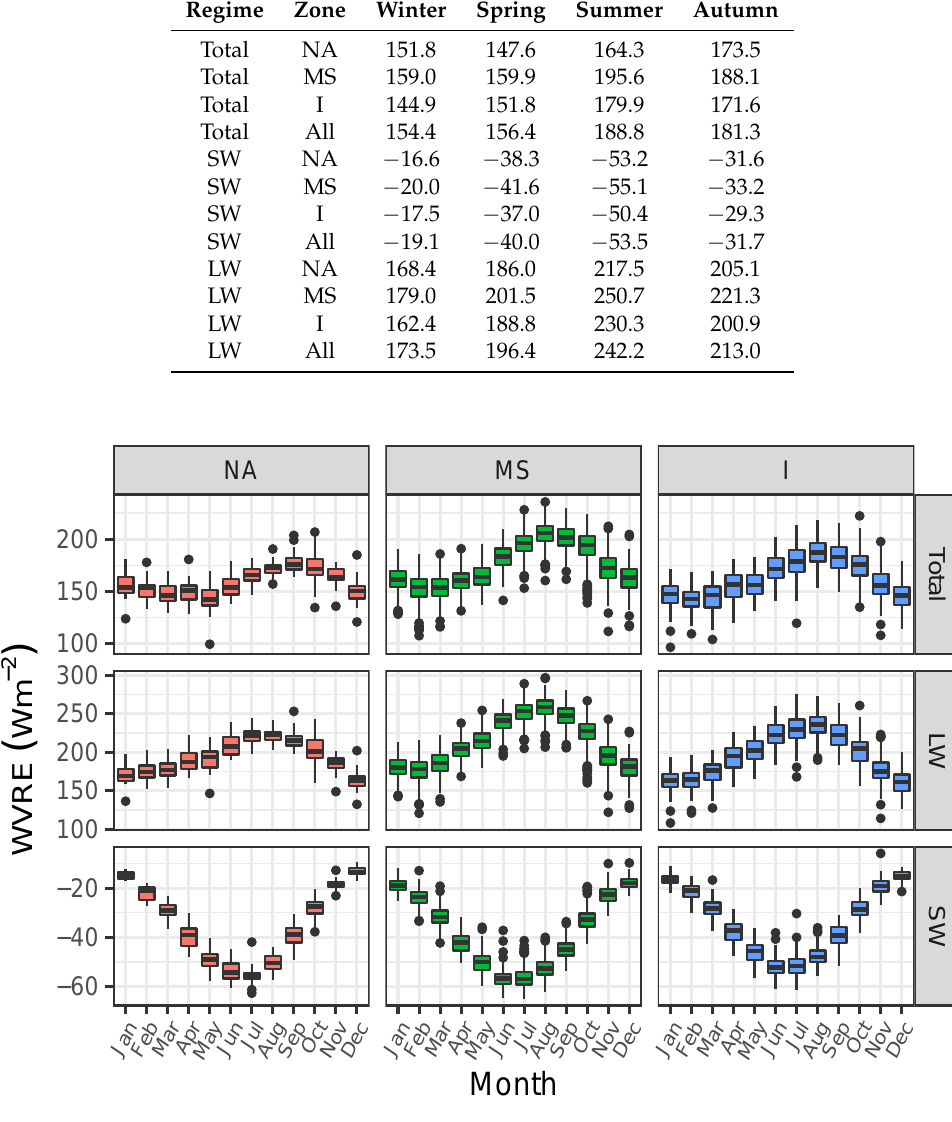
Figure 2. Water vapor radiative effects (WVRE) seasonal evolution in the regions considered in this study, in the form of a